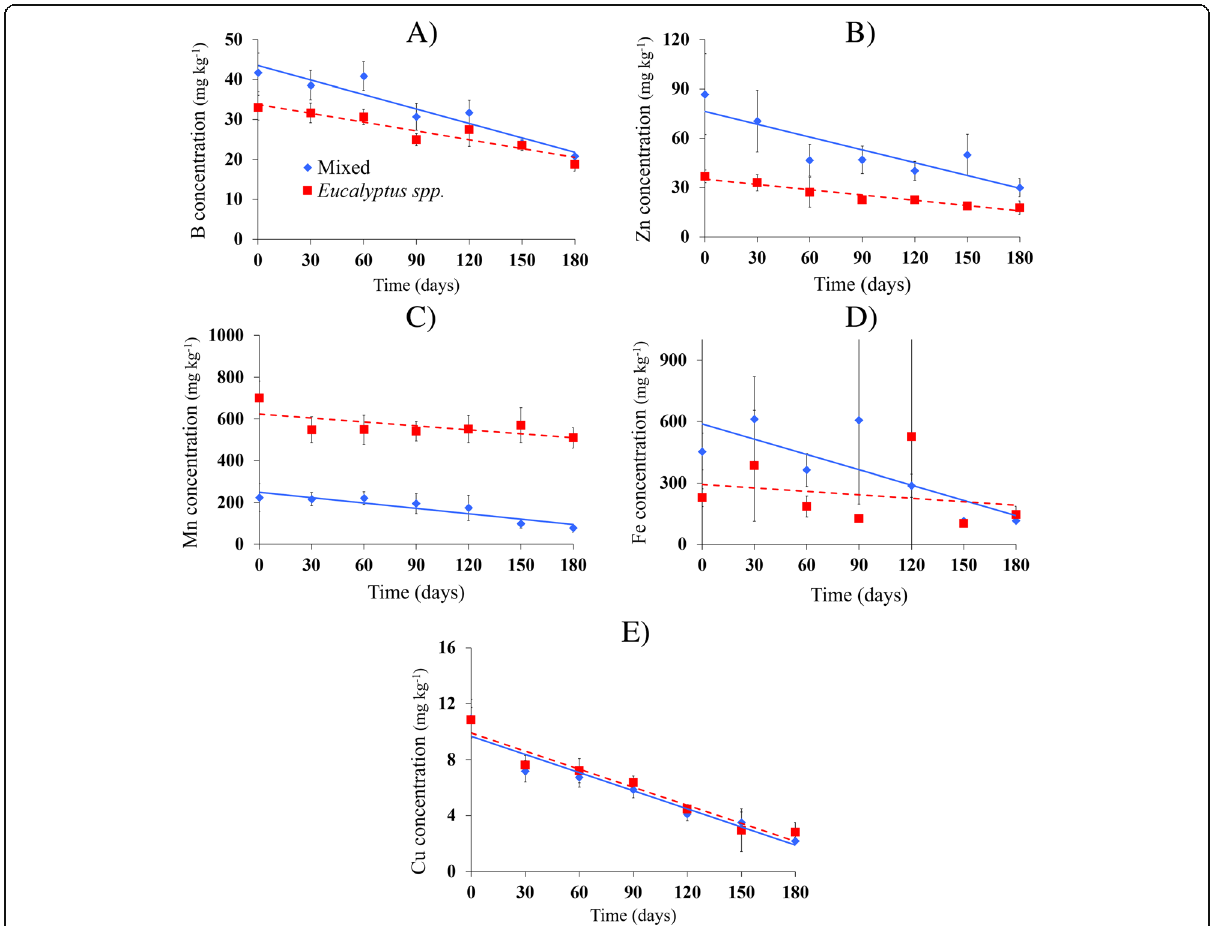
Fig. 4 Loss of micronutrients over time in mixed species (diamonds with blue lines) and Eucalyptus spp. (red squares with dotted lines). a Boron loss, b zinc loss, c manganese loss, d iron loss, e copper loss Table 5 Relative values of nutrients and mass loss in mixed and Eucalyptus spp. litter between the first and last month of observation. N nitrogen, P phosphorus, K potassium, Ca